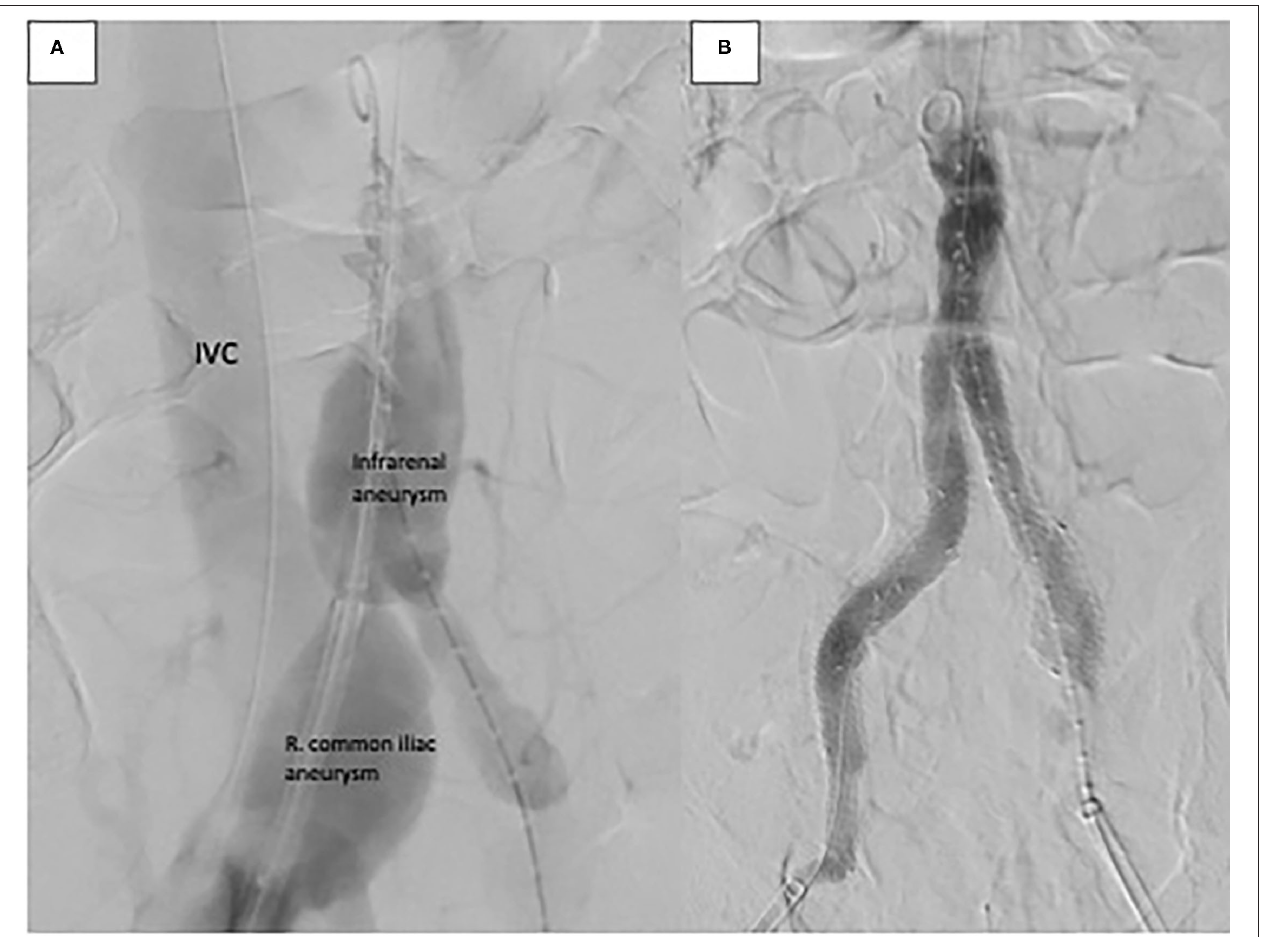
FIGURE 3 | Intra-operative angiography. (A) Aortogram demonstrating infrarenal and right common iliac aneurysm with rapid filling of inferior vena cava (IVC) suggesting aortovenous fistula. (B) Aortogram after endovascular repair demonstrating exclusion of aortoiliac aneurysms and fistula.